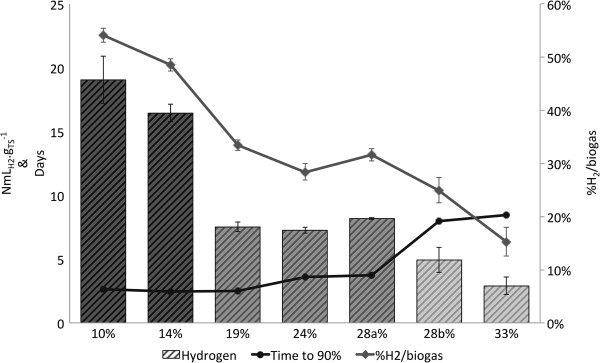
Biohydrogen production for the six TS contents tested. Results are expressed in terms of maximal volume, percentage of hydrogen produced, and time to achieve 90% of the total hydrogen production. These fermentation performances distinguished three groups of TS content. TS, total solids.